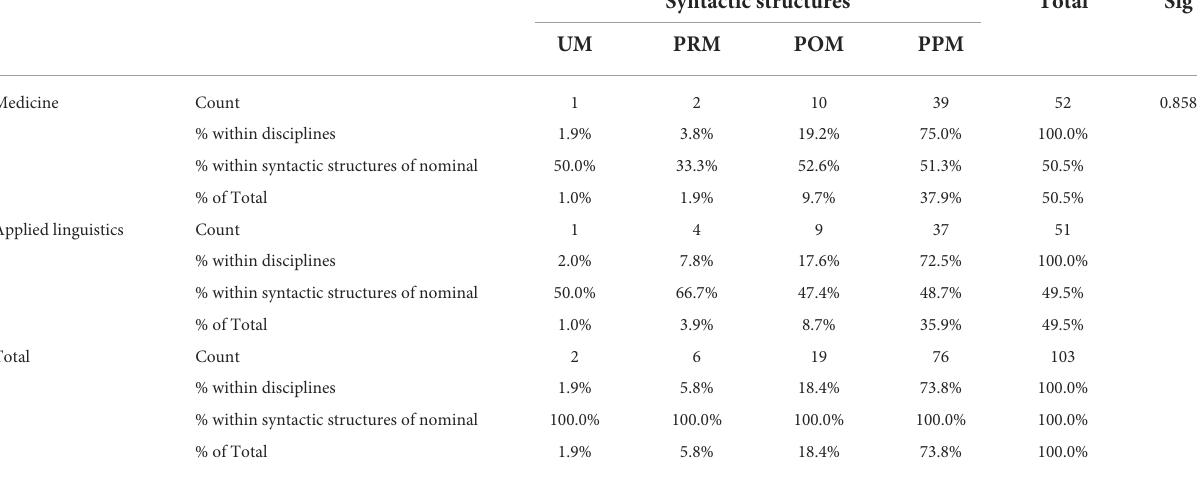
TABLE 5 Frequency and percentage of syntactic structures of nominal constructions in single-unit titles in the two disciplines (chi-square test). Syntactic